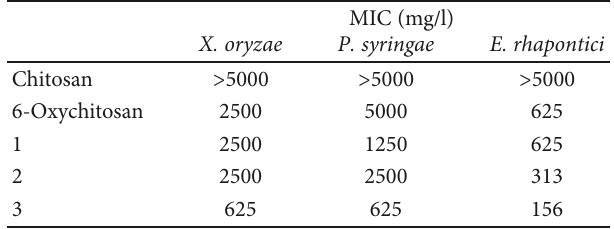
Table 2: The minimum inhibitory concentrations (MICs) of chitosan, 6-oxychitosan, 1, 2, and 3 against X. oryzae , P. syringae , and E. rhapontici in the 96-well polystyrene microtiter